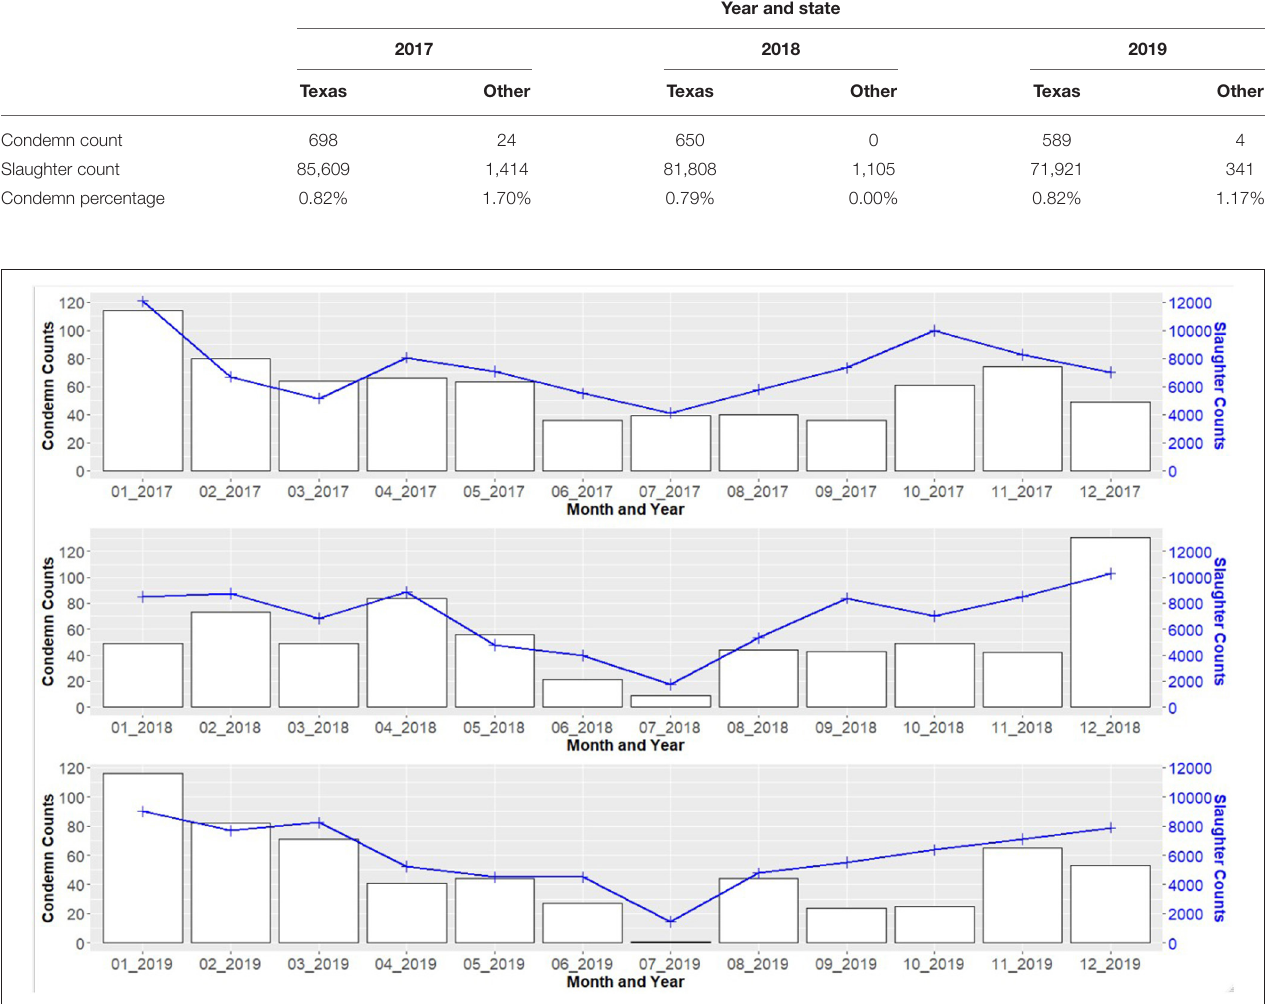
FIGURE 2 | Feral swine slaughter and condemnation counts by month, 2017–2019.